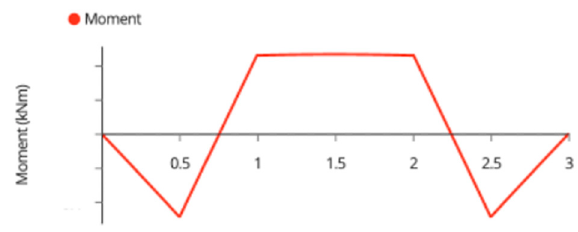
Figure A7. Beam bending moment diagram.